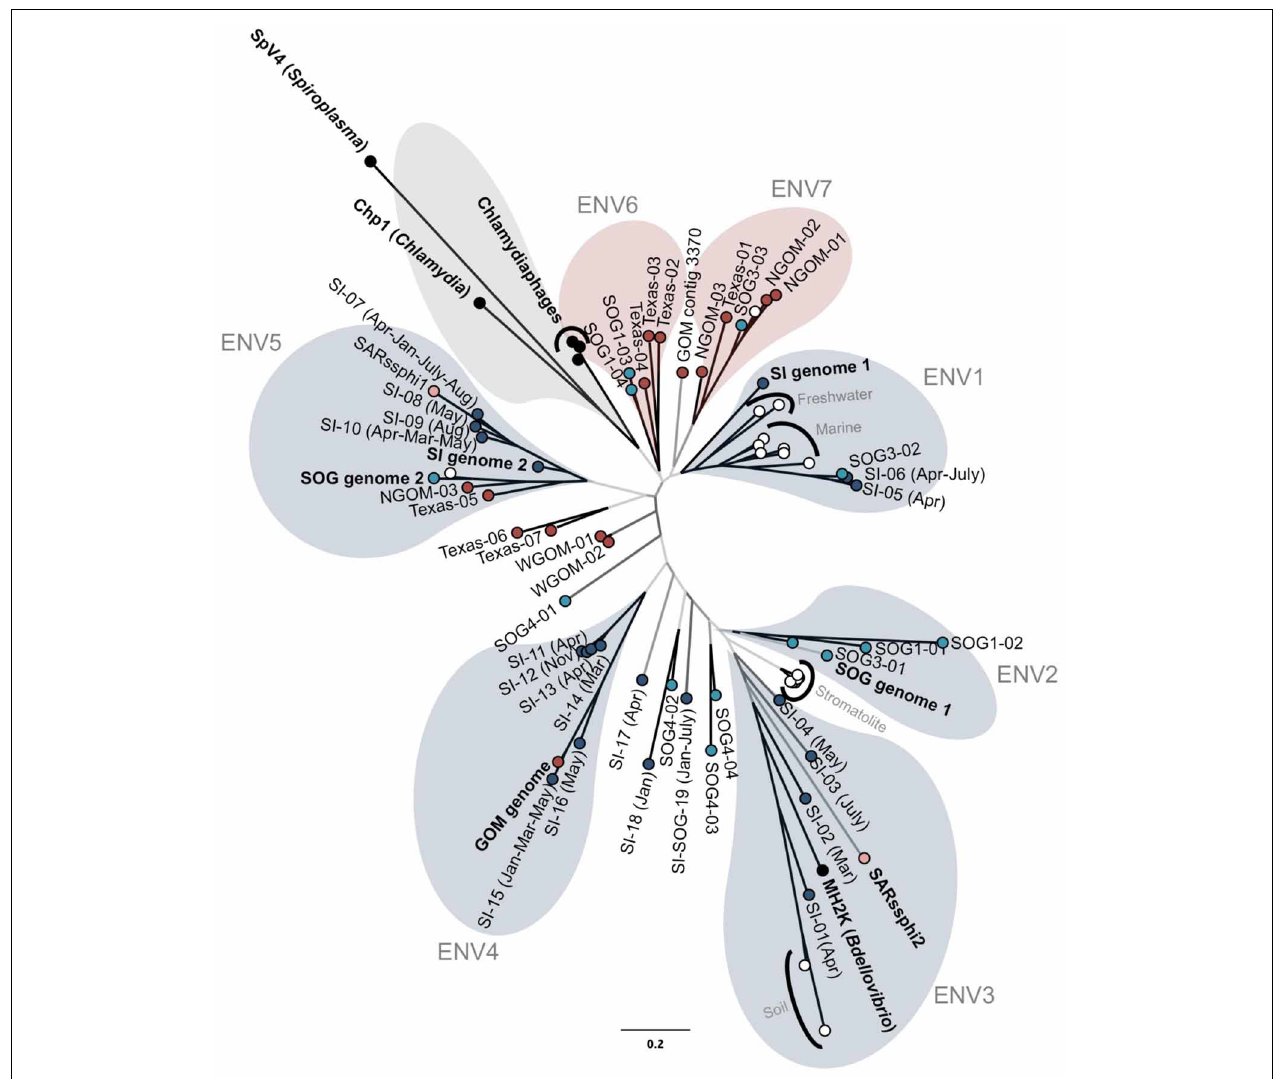
FIGURE 2 | Genetic relatedness of the major capsid protein gene VP1. Unrooted Bayesian phylogenetic analysis (20 million MCMC generations with 25% burnin; HKY85 model) of PCR products from GOM (red), Strait of Georgia (light blue), Saanich Inlet (dark blue), cultured isolates (black), and other environmental sequences (white). Bootstrap support of at least 90%, 75%